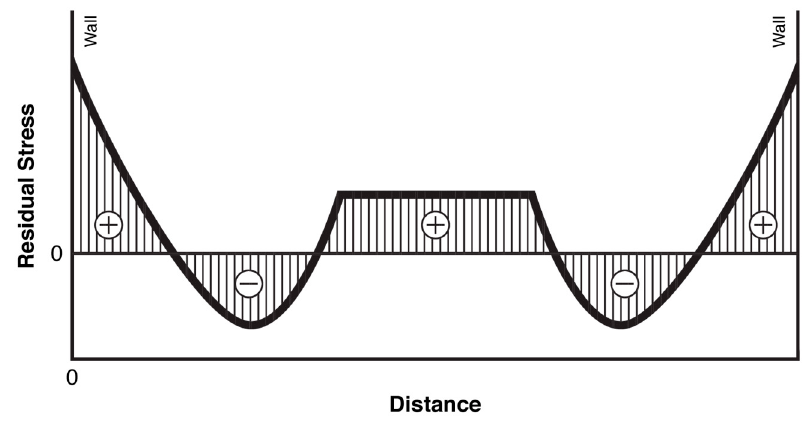
Figure 1. Scheme of residual stress in a cross-section of an injection molded part [2].